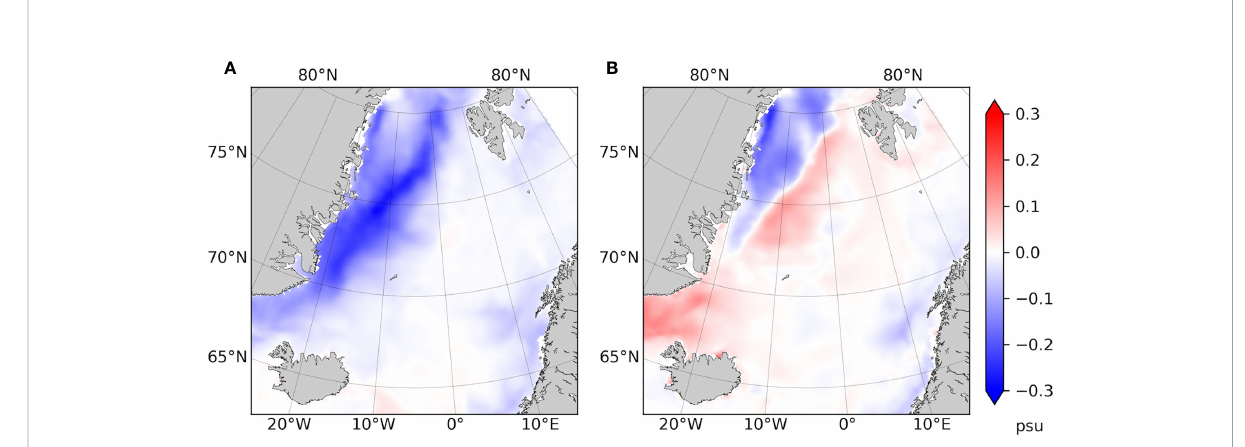
FIGURE 7 Spatial pattern of the (A) fi rst and (B) second mode Empirical Orthogonal Function of near-surface salinity anomaly for the period of